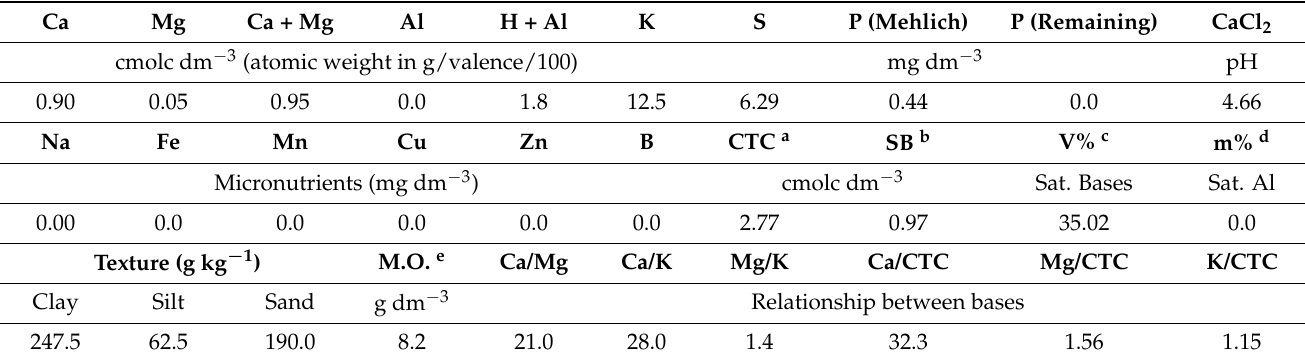
Table 2. Chemical and physical characteristics of the soil used in the experiment of growth promotion of Glycine max by microbial isolates obtained from Hymenaea courbaril and Butia purpurascens in a controlled greenhouse